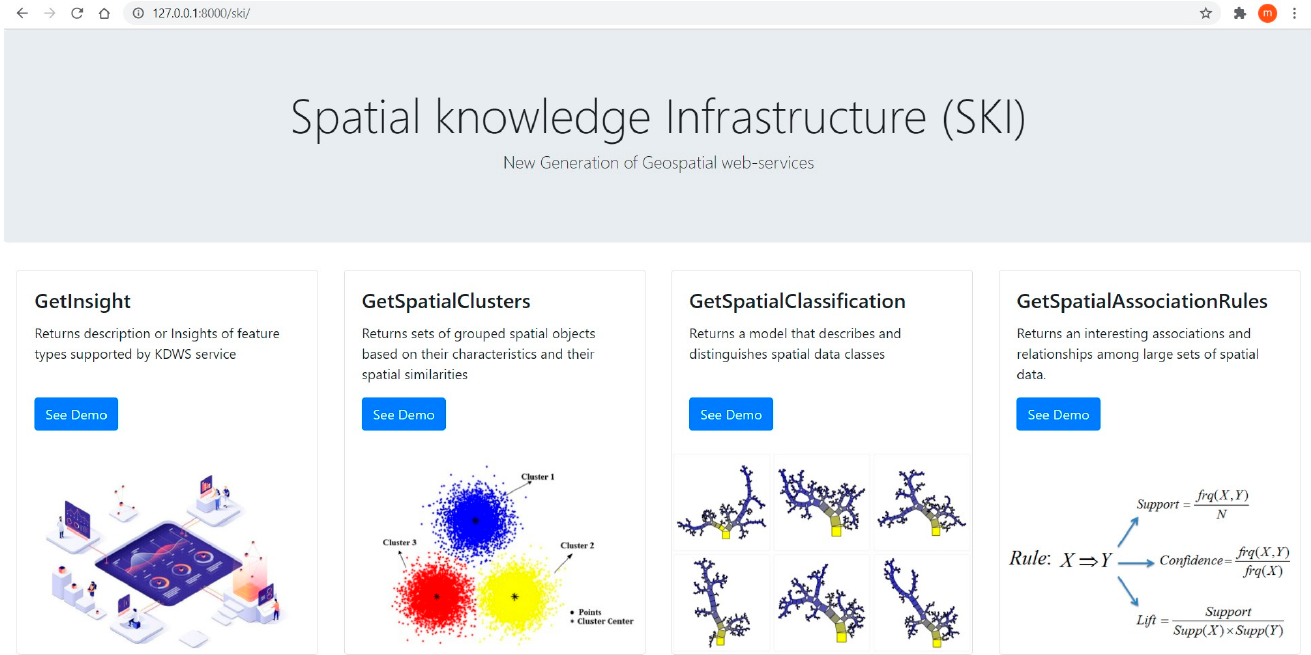
Figure 11. A prototype system developed to use the